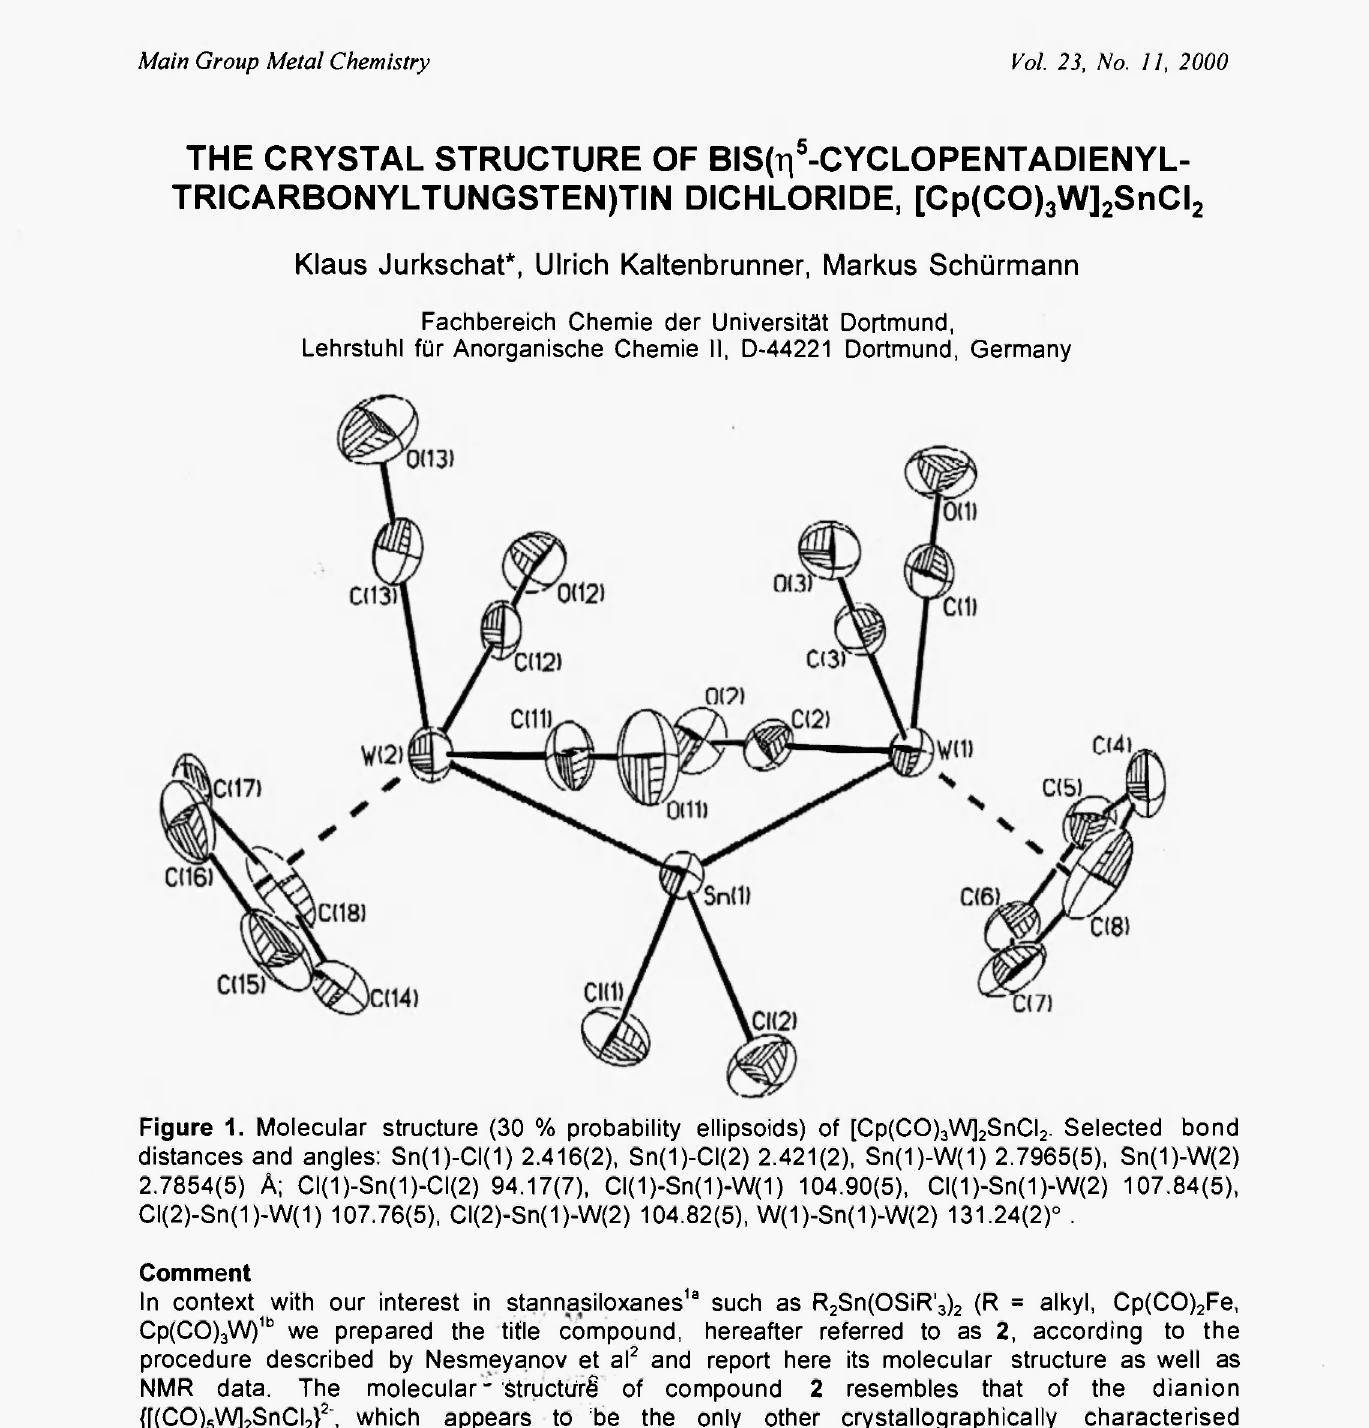
Figure 1. Molecular structure (30 % probability ellipsoids) of [Cp(CO) 3 W] 2 SnCI 2 . Selected bond distances and angles: Sn(1)-CI(1) 2.416(2), Sn(1)-CI(2) 2.421(2), Sn(1)-W(1) 2.7965(5), Sn(1)-W(2) 2.7854(5) A; CI(1)-Sn(1)-CI(2) 94.17(7), Cl(1)-Sn(1)-W(1) 104.90(5), Cl(1)-Sn(1)-W(2) 107.84(5), Cl(2)-Sn(1)-W(1) 107.76(5), Cl(2)-Sn(1)-W(2) 104.82(5), W(1)-Sn(1)-W(2) 131.24(2)°